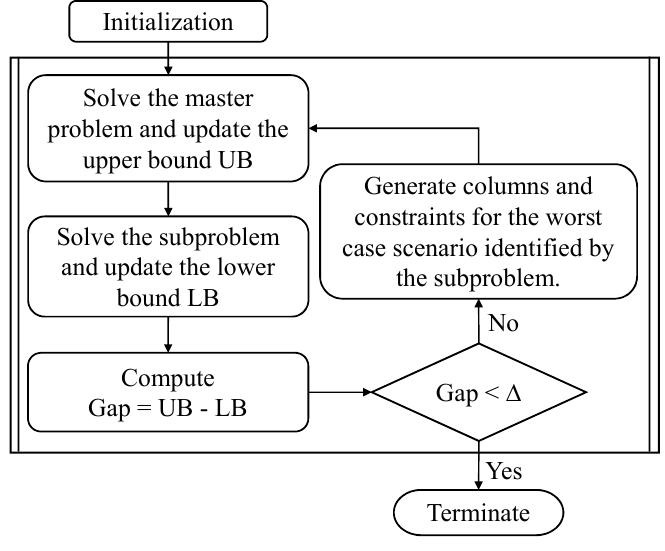
Figure 3. The Primal Cut Algorithm [19] Figure 3. The primal cut algorithm